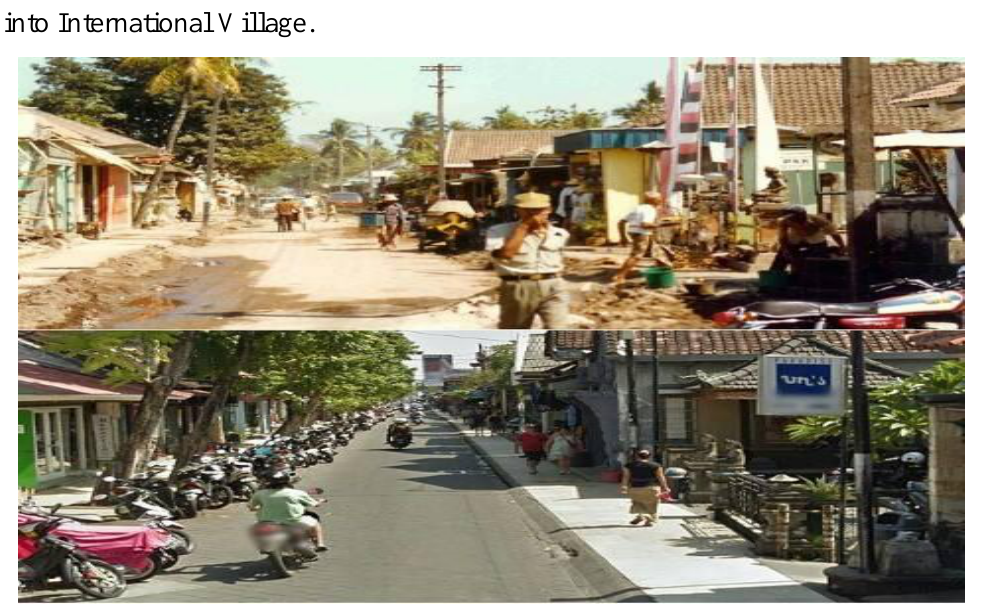
Picture 1. The Condition of Jalan Raya Kuta in 1983 (above) and present condition (below)